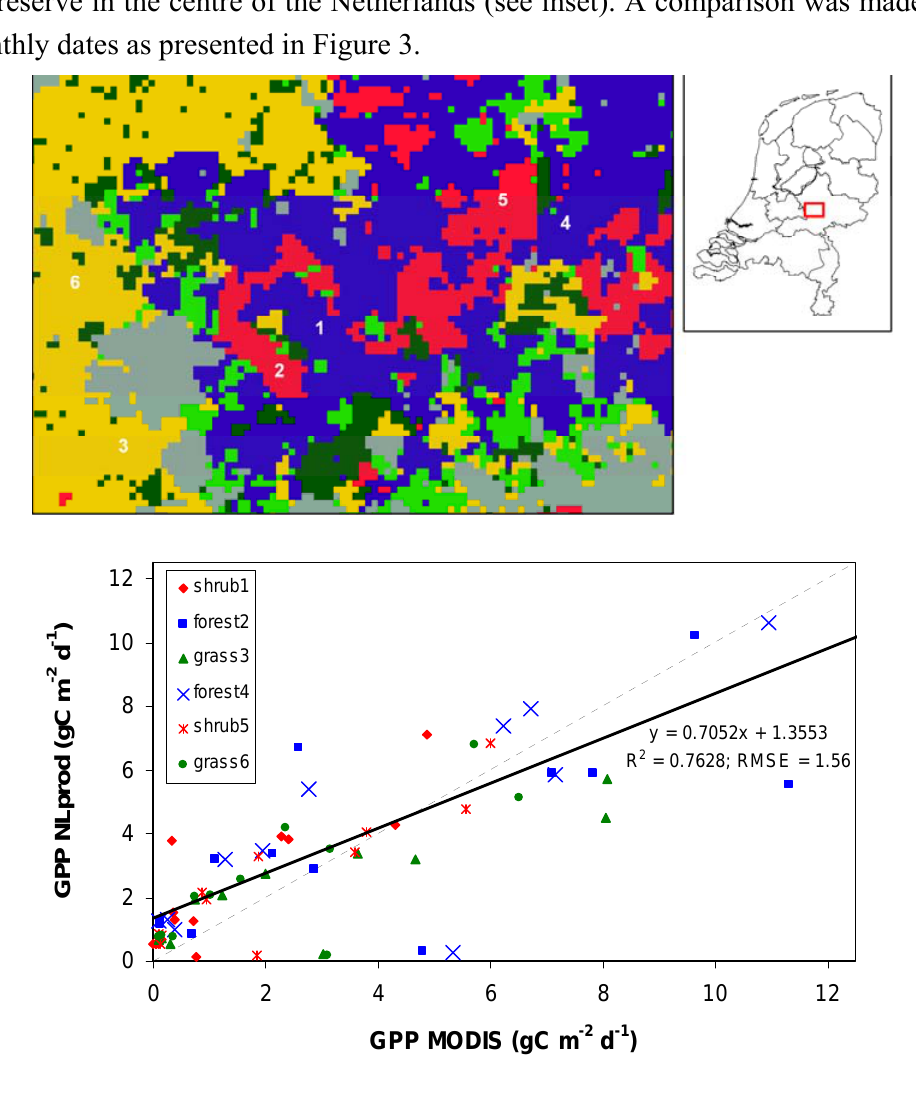
Figure 6. Comparison of 8-day MODIS GPP product (MOD17A2) with daily